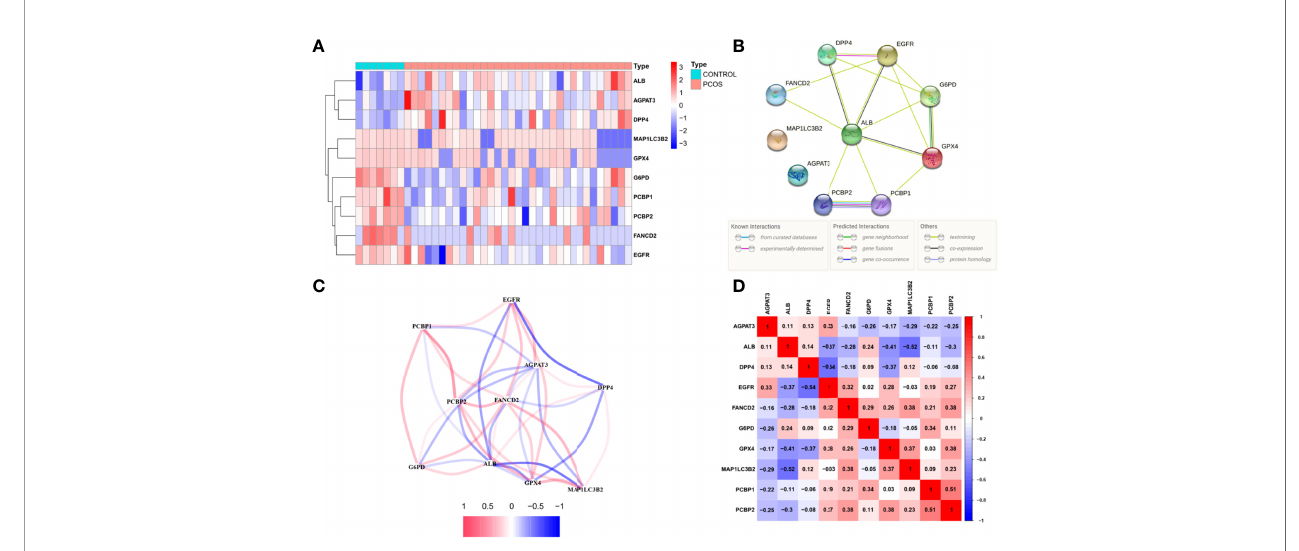
FIGURE 3 | Ferroptosis relative proteins differential analysis.